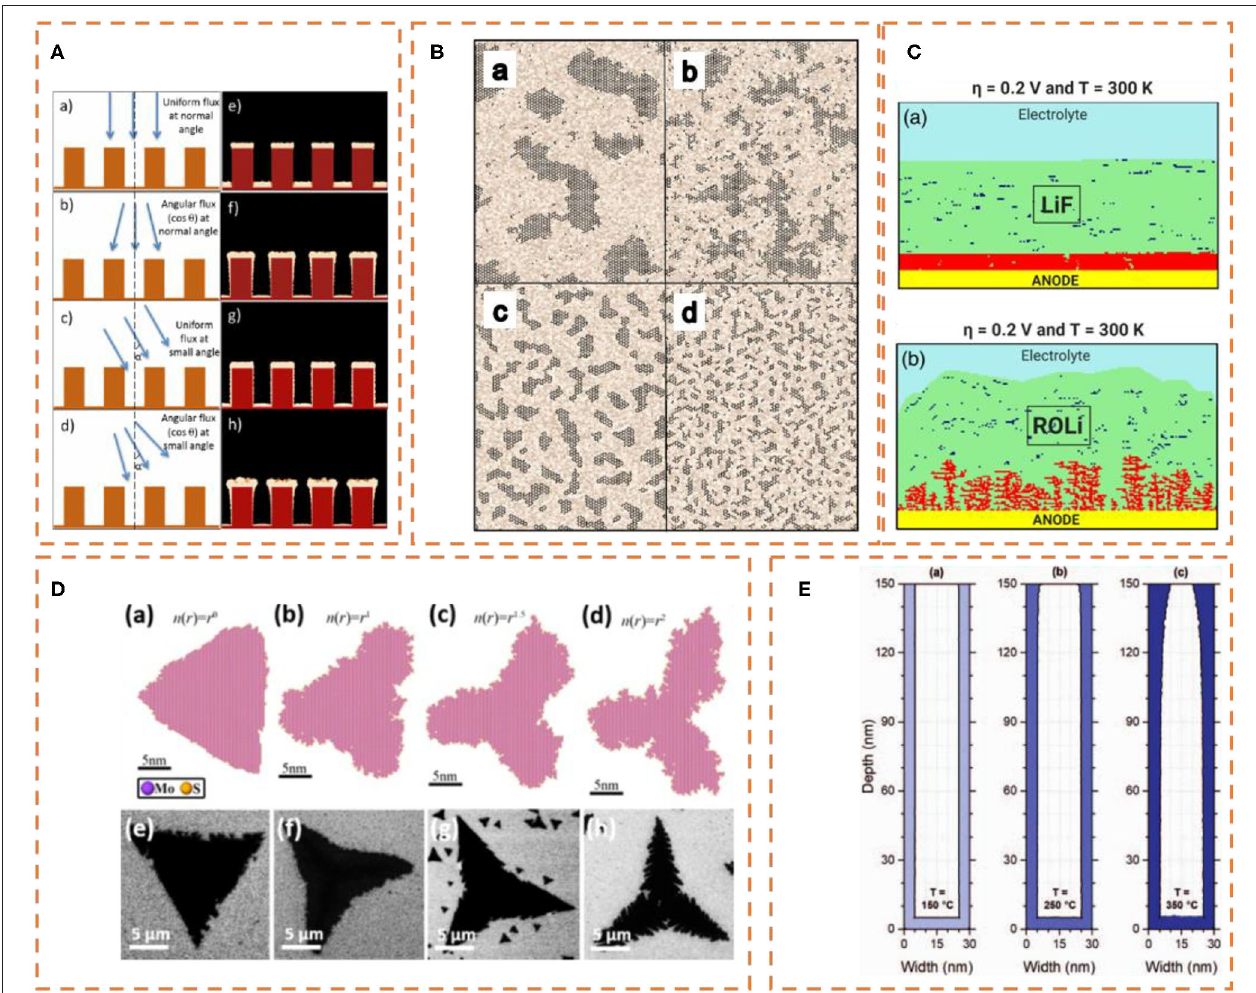
FIGURE 2 | (A) PVD of Ag core/shell on In 2 S 3 nanorods: MC results for four different conditions: (a,e) Uniform incident flux, α = 0 ◦ ( α is the angle between the incoming flux and the surface normal to the substrate), (b,f) angular flux ∼ cos( θ ) with α = 0 ◦ , (c,g) uniform flux with α = 30 ◦ and (d,h) angular flux ∼ cos( θ ) with α = 30 ◦ . Reprinted with permission from Metropolis et al. [ 6] - Published by the IEEE. (B) Graphene CVD: MC results for varying strength of surface roughness parameter ξ and mobility parameter T s for (a) ξ = 1.2, T s = ∞ (b) ξ = 1.5, T s = ∞ (c), ξ = 1.5, T s = 0 and (d) ξ = 1.2, T s = 0. The color represents roughness. Reprinted with permission from Yang et al. [ 23] - Published by the PCCP Owner Societies. (C) Electrodeposition in Li metal anode: kMC results for (a) uniform Li deposition in LiF electrolyte, (b) dendrite growth in ROLi electrolyte. The red particles represent the Li metal which is being deposited, and the dark-blue particles represent the Li +